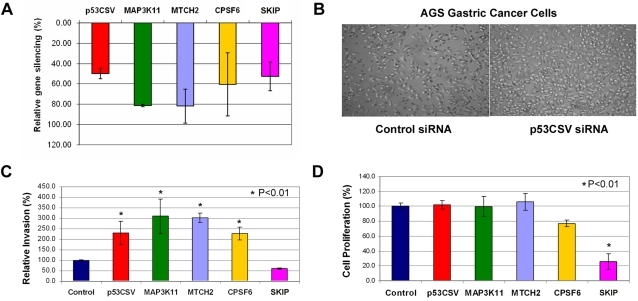
Reducing PGC gene expression by siRNA enhances the invasive behavior of AGS gastric cancer cells.A) Real-time PCR quantification of siRNA mediated knockdown efficiency of five PGC genes (p53CSV, MAP3K11, MTCH2, CPSF6 and SKIP). The y-axis represents the percentage of relative silencing achieved by the different siRNA treatments. Relative silencing was calculated by comparing PGC gene expression levels between cells treated with either control or PGC target siRNAs. For each siRNA treatment, the expression levels of the PGC genes were normalized against the GADPH expression level. B) Representative photographs of AGS cells in the matrigel invasion assay. The left panel depicts control siRNA treated cells, while the right panel indicates p53CSV siRNA treated cells. Note the increased number of invading cells in the right panel. C) Summary graph of invasion effects caused by PGC gene silencing. Significant enhancements in cellular invasion were observed for p53CSV, MAP3K11, MTCH2, CPSF6 (* symbols, P<0.01). P-values were calculated using a one-tailed t-test. D) Summary graph of cell proliferation effects caused by PGC gene silencing. Significant reductions in cell proliferation were only observed for the SKIP siRNA treatments. P-values were calculated using a one-tailed t-test.